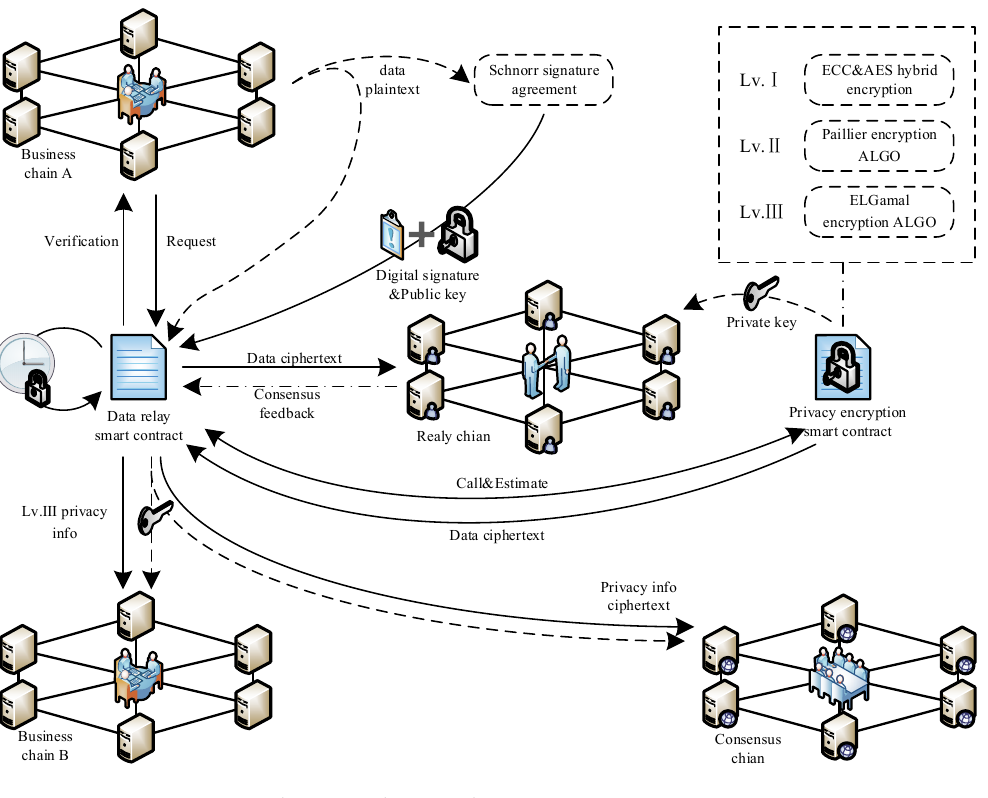
Figure 4. Relay cross-chain mode.